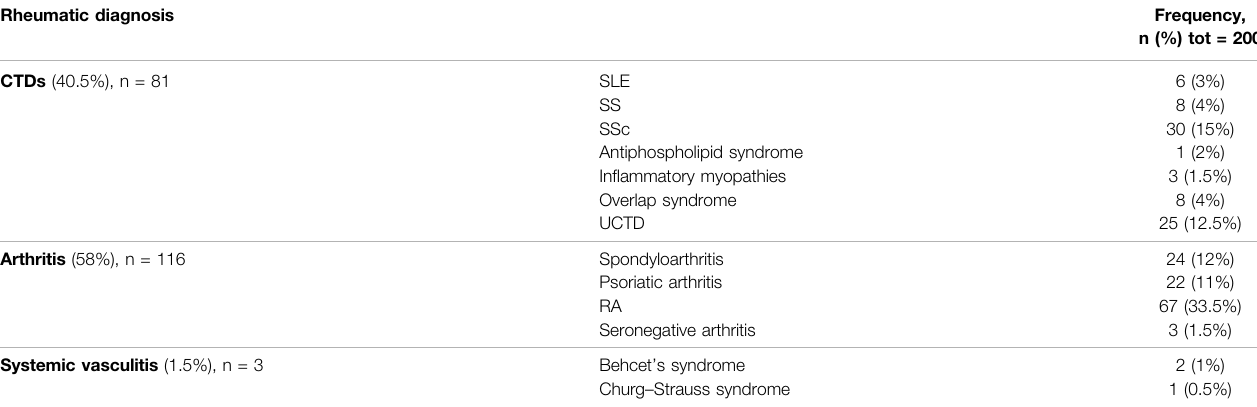
TABLE 1 | Detailed rheumatological diagnosis of the patients included in the study. Rheumatic